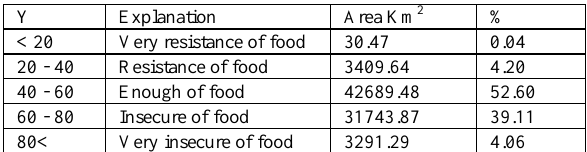
TABLE 11. Classification of food